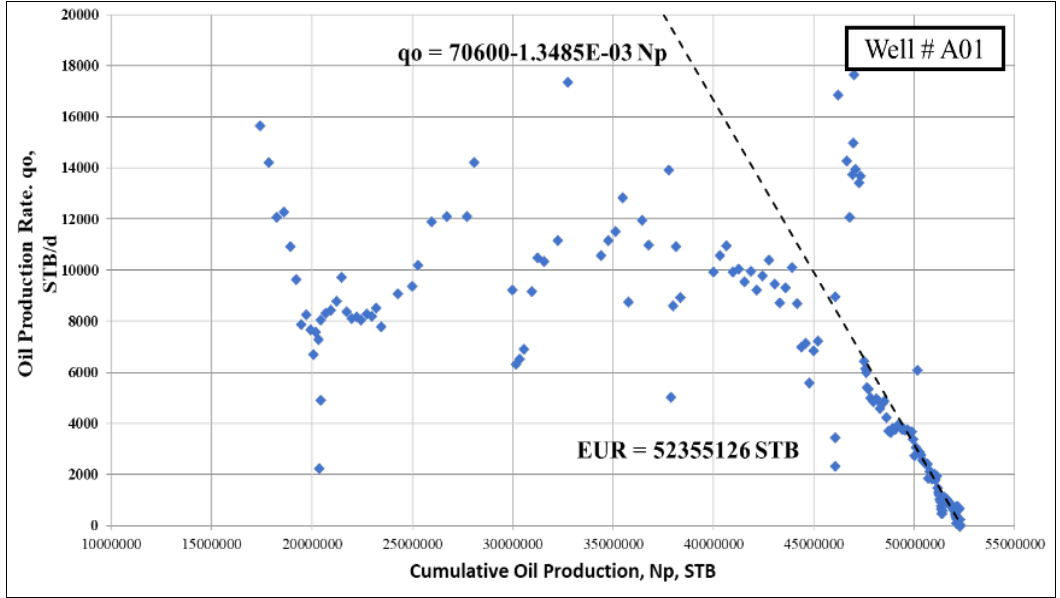
Figure 4. Oil production rate versus production time for well A28